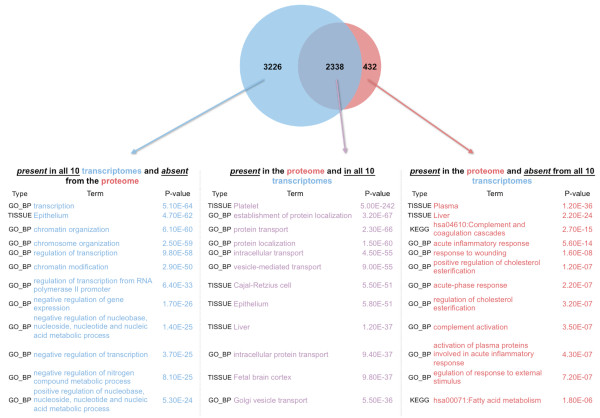
Three groups of platelet genes. A) Venn iagram showing the number of genes contained in each of the three shown categories of genes. Note that the five categories are non-overlapping. B) Top entries of DAVID analysis for the GO, KEGG pathway, and UP_TISSUE terms corresponding to the genes contained in each of the categories shown in the A) panel.